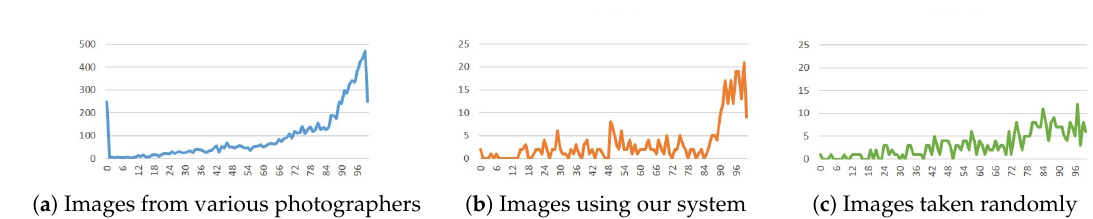
Figure 41. Results for the rule-of-thirds composition method.